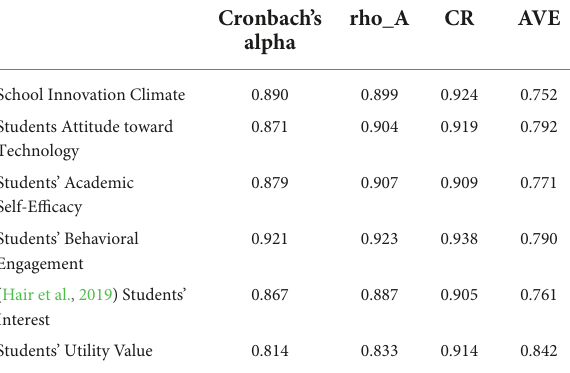
TABLE 2 Outer loadings. TABLE 3 Construct reliability and